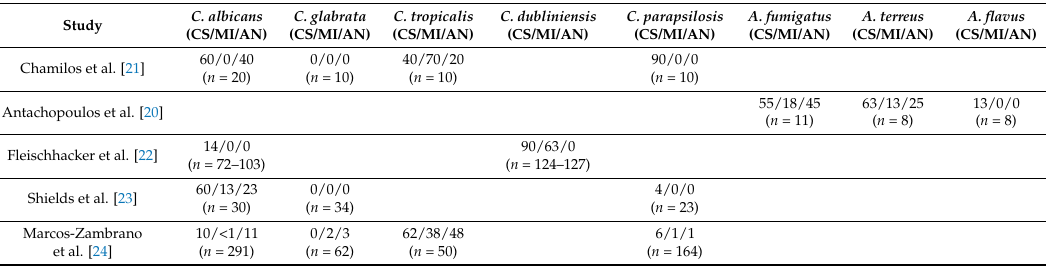
Table 1. Manifestation frequency of the paradoxical effect in vitro in percent (%) of caspofungin (CS), micafungin (MI), and anidulafungin (AN) among clinical isolates of selected Candida and Aspergillus species in different studies. The numbers of tested isolates (n) are given in brackets. Paradoxical growth was determined with CLSI (Clinical and Laboratory Standards Institute)-[21–23], EUCAST (European Committee on Antimicrobial Susceptibility Testing)-[24], or metabolism-based [20] broth microdilution methods in RPMI 1640-based